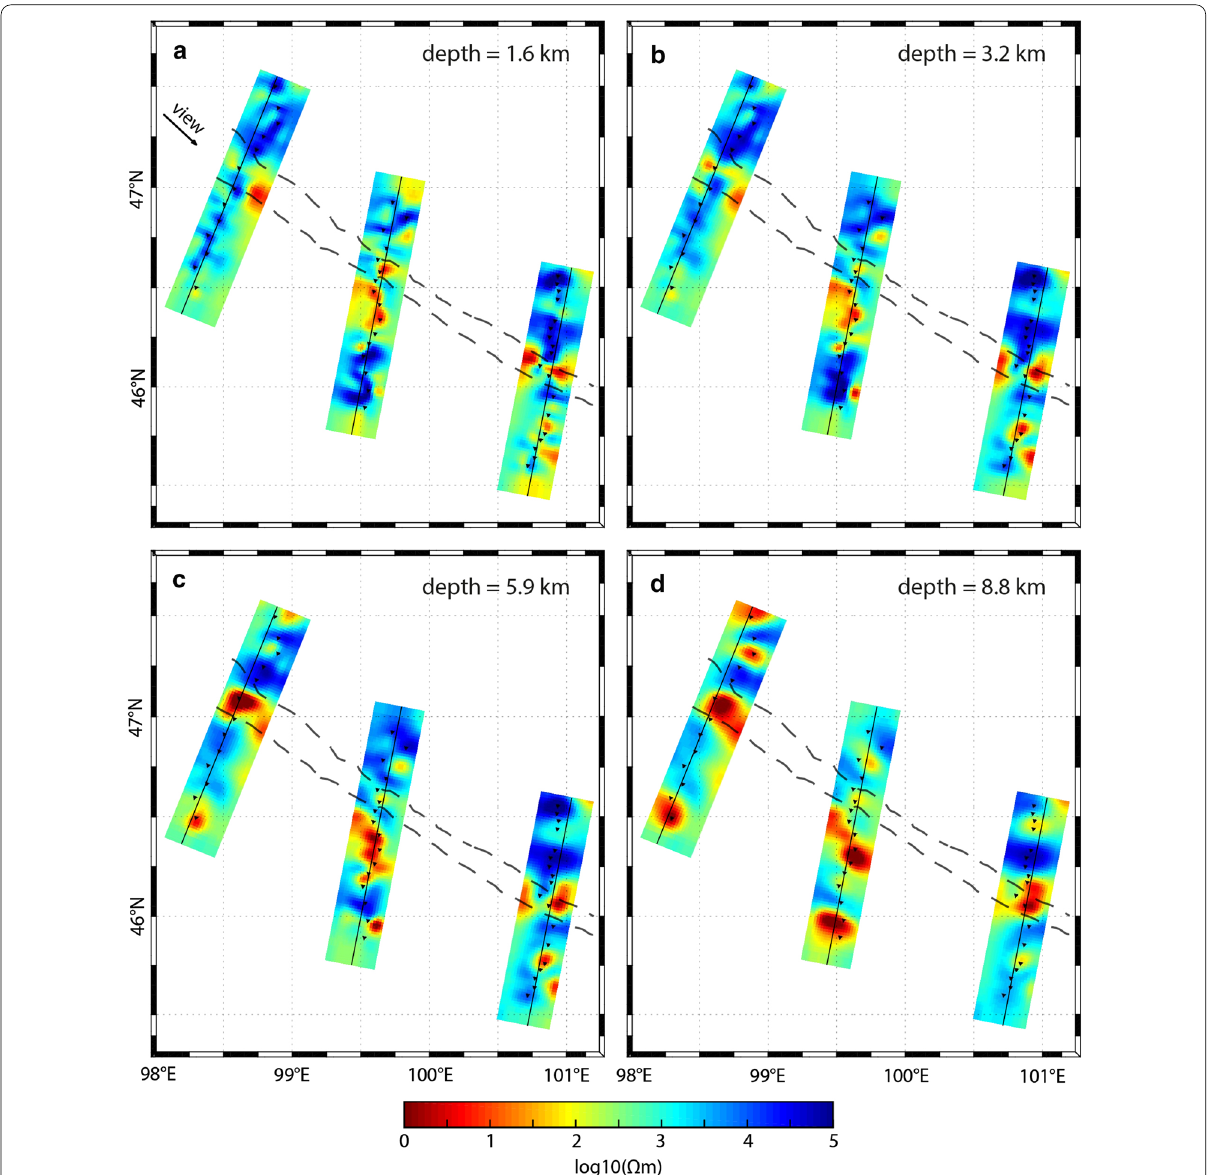
Fig. 8 Horizontal slices of the 3-D electrical resistivity models. They are shown in map view for depths of approximately a 1.6 km, b 3.2 km, c 5.9 km, and d 8.8 km. The models were obtained with the MODEM inversion algorithm. The locations of MT measurement sites are indicated with black triangles. The approximate location of the Bayankhongor Ophiolite Belt is marked (dashed lines, as in Fig. 1). An arrow marks the direction of the oblique view from Fig.